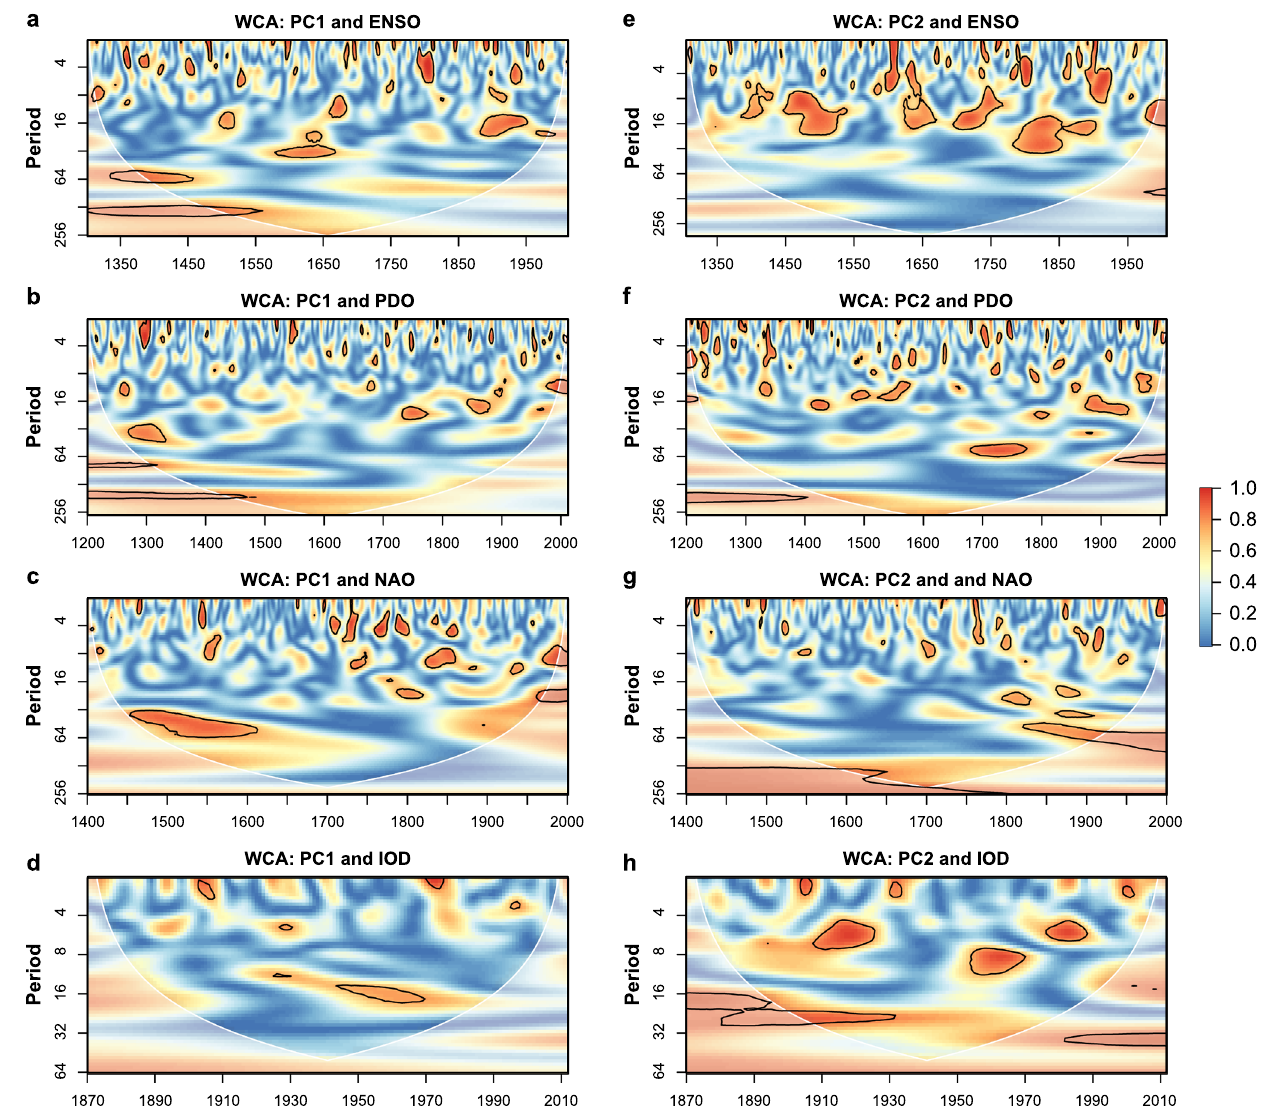
Fig. 4 | Wavelet coherence analysis between leading principal components (PCs) of reconstructed stream fl ow and large-scale climate patterns. a – d show the wavelet coherence between PC1 of reconstructed stream fl ow and four large- scale climate patterns, i.e., El Niño Southern Oscillation (ENSO), Paci fi c Decadal Oscillation (PDO),North AtlanticOscillation(NAO),and Indian OceanDipole(IOD) that signi fi cantly affect PC1 of reconstructed stream fl ow. Wavelet coherence ana- lysis between PC2 of reconstructed stream fl ow and the four large-scale climate